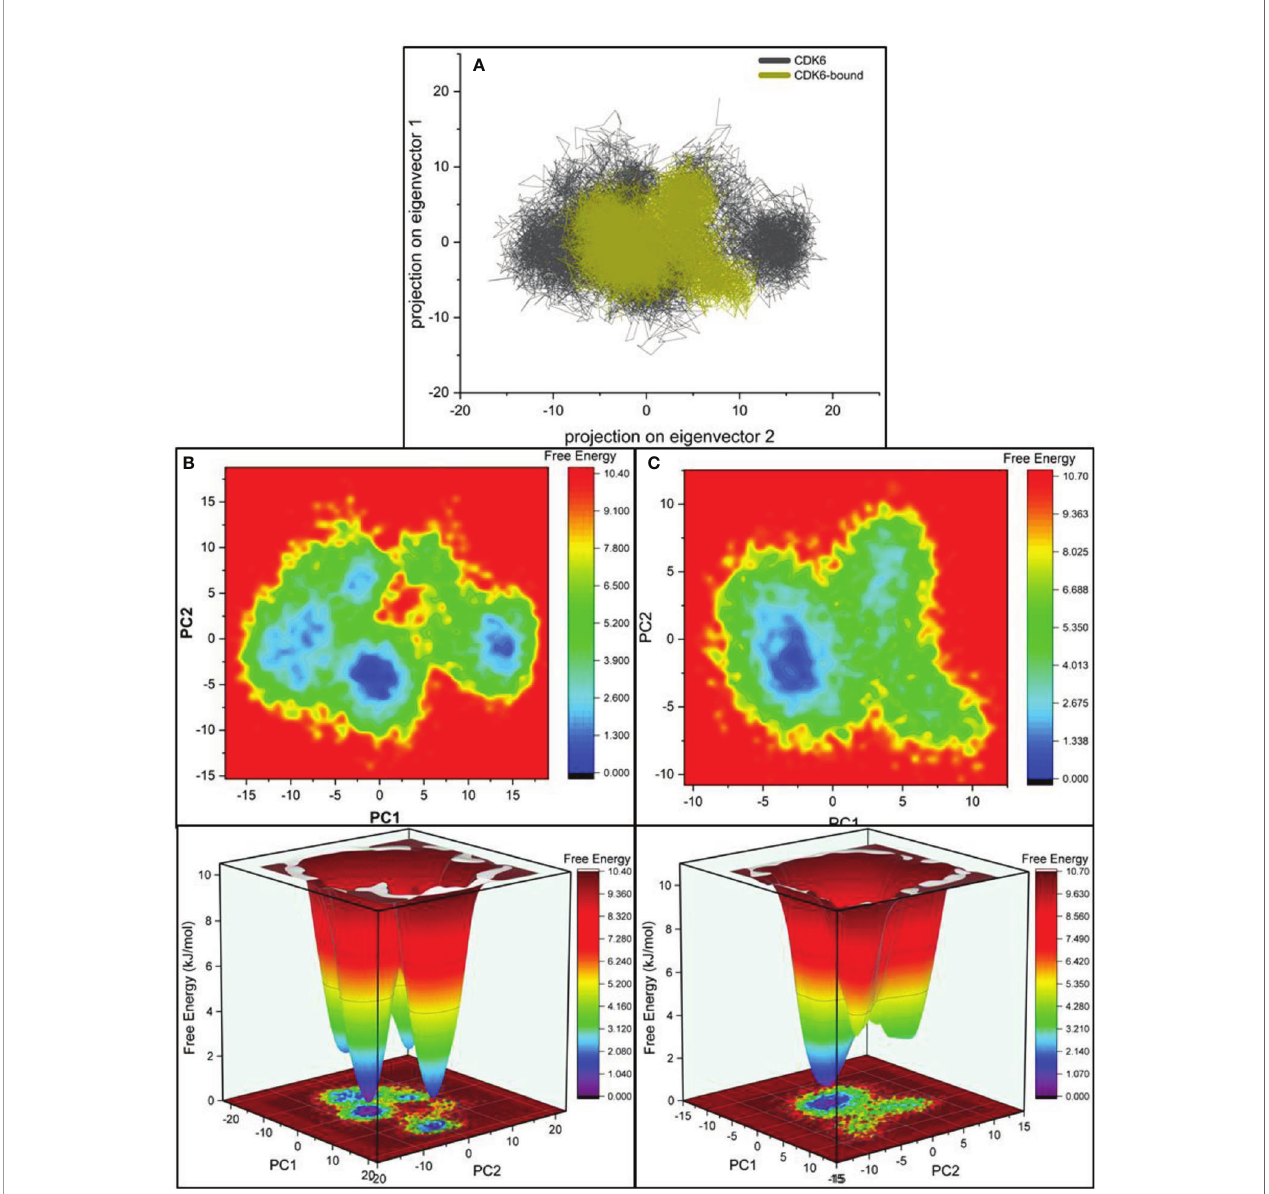
FIGURE 5 | (A) Projections of the eigenvectors for PCA analysis of CDK6 complexed with selonsertib. Free energy contour for the (B) CDK6 and (C) selonsertib bound structure of CDK6.